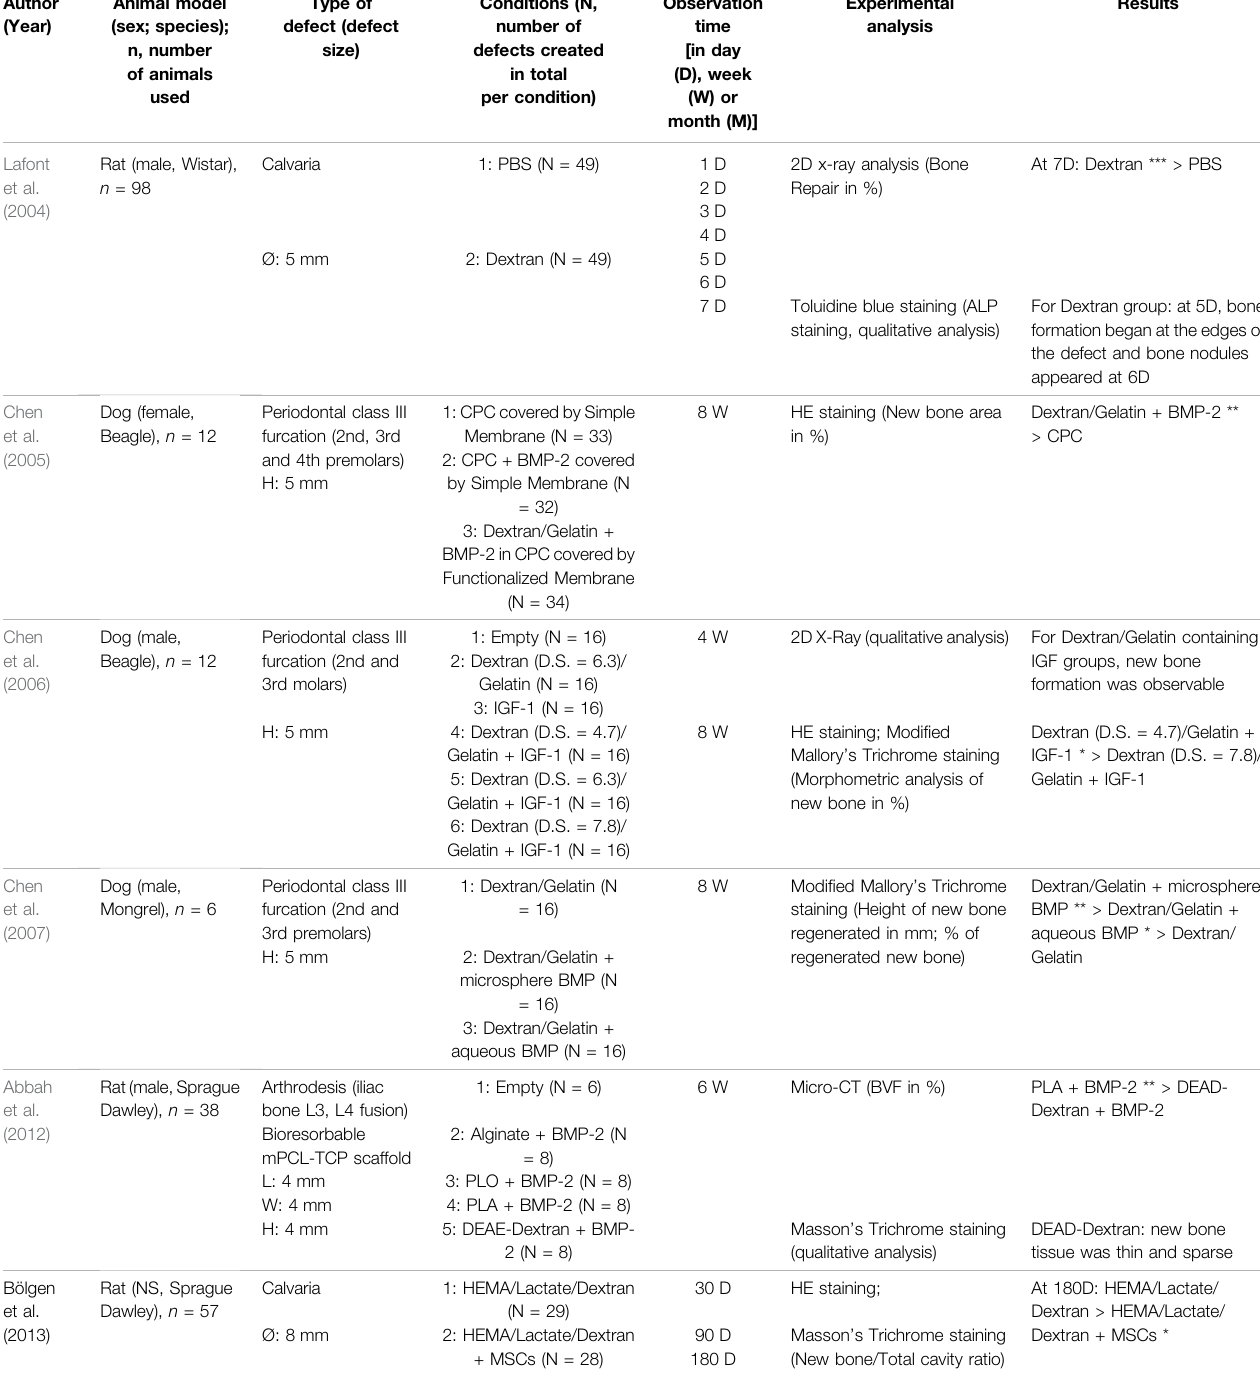
TABLE 3 | Preclinical studies using Dextran scaffolds for bone regeneration in orthotopic sites. Author